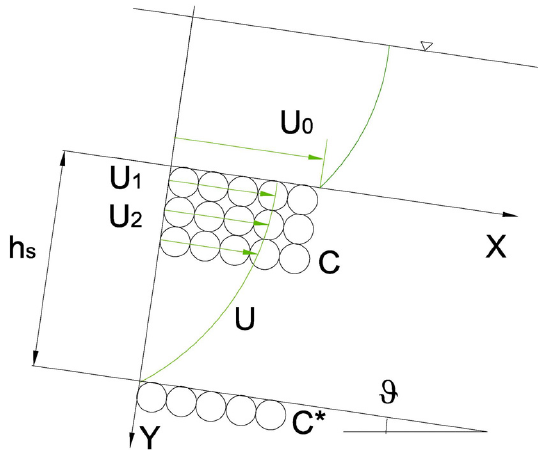
of a flow over an erodible bed. Profiles for s Fig. 3. Sketch of the sediment transport